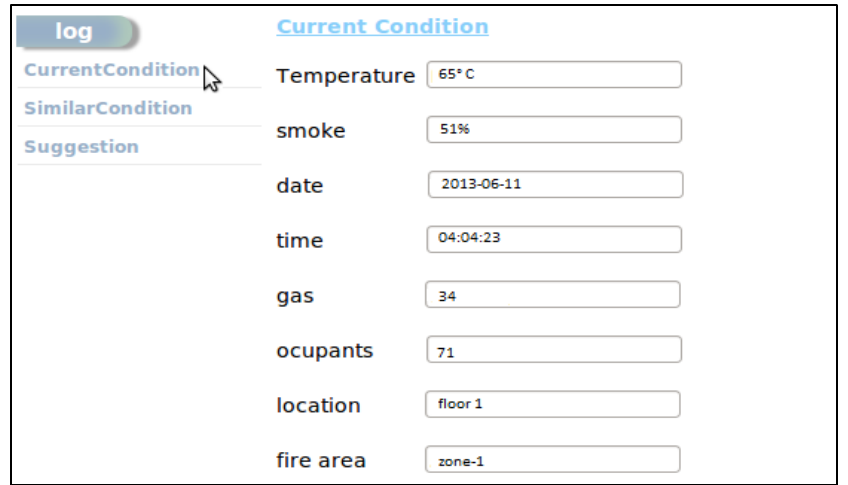
Figure 16. Current condition in the fire affected area.